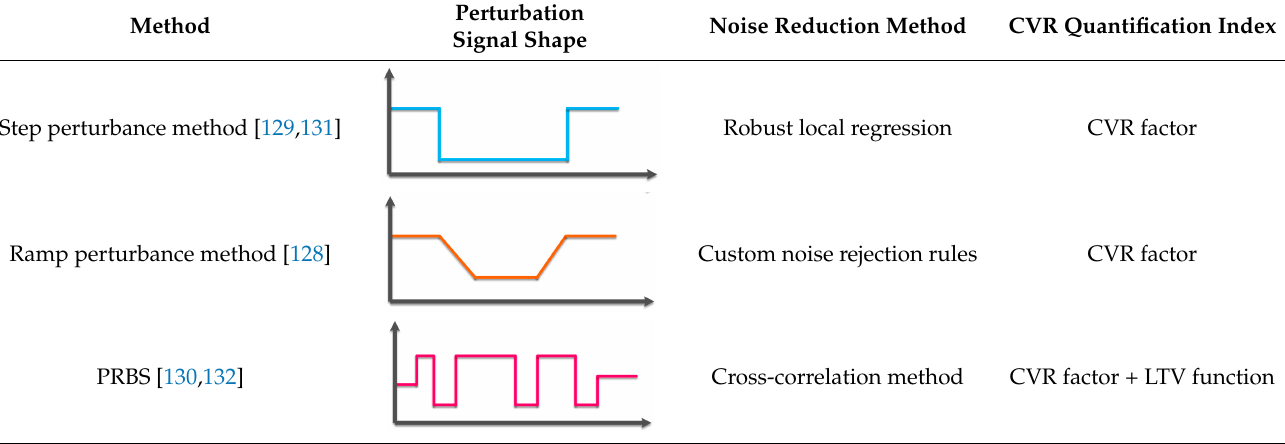
Table 3. Methodology of the different perturbation-based quantification techniques.